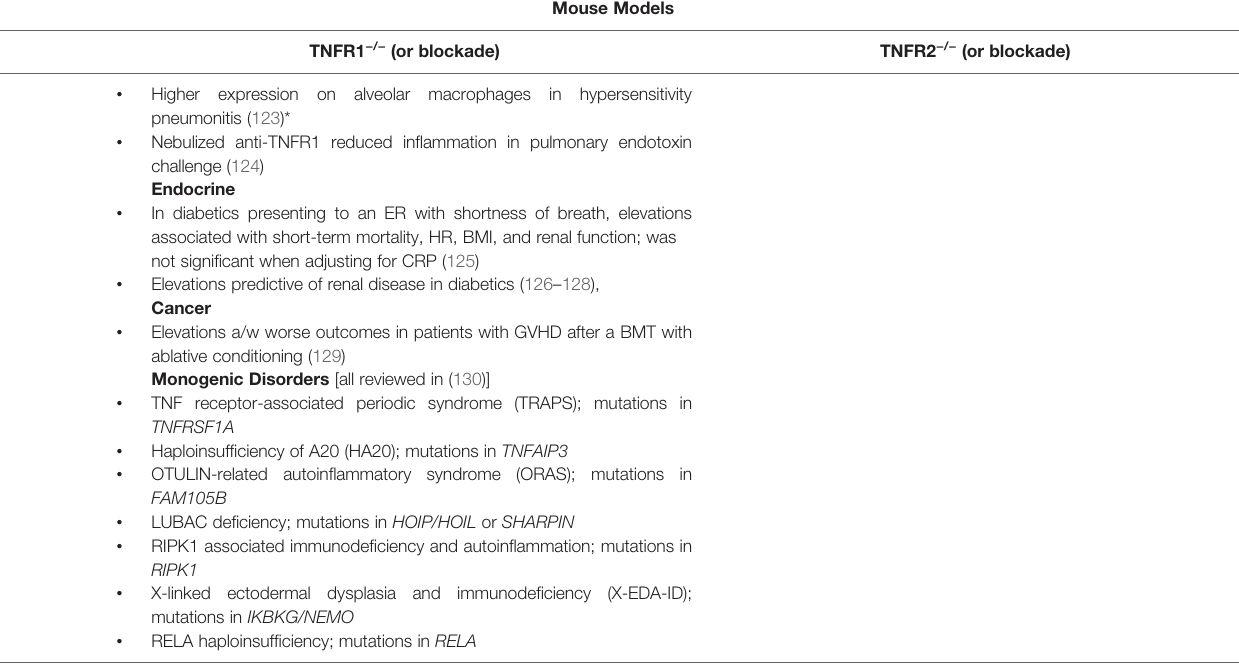
Mouse models included in the table indicate selective deletion or antibody blockade of TNFR1 or TNFR2. Models using only TNFR double knockout mice were not included. Human data for diseases associated with changes in one TNFR (serum or tissue) are shown. *indicates opposing effects of TNFR deletion (for example, deletion of TNFR1 worsening outcomes while deletion of TNFR2 improving them); $ indicates similar effects of TNFR deletion where both were assessed independently. LPS, lipopolysaccharide; DSS, dextran sodium sulfate; COPD, chronic obstructive pulmonary disorder; HSV-1, herpes simplex virus 1; TCR, T-cell receptor; ER, emergency room; HR: heart rate; BMI, body mass index; CRP, C-reactive protein; GVHD, graft versus host disease; BMT, bone marrow transplant; CFA, complete Freud ’ s adjuvant; LPS, lipopolysaccharide; PBMC, peripheral blood mononuclear cells; a/w, associated